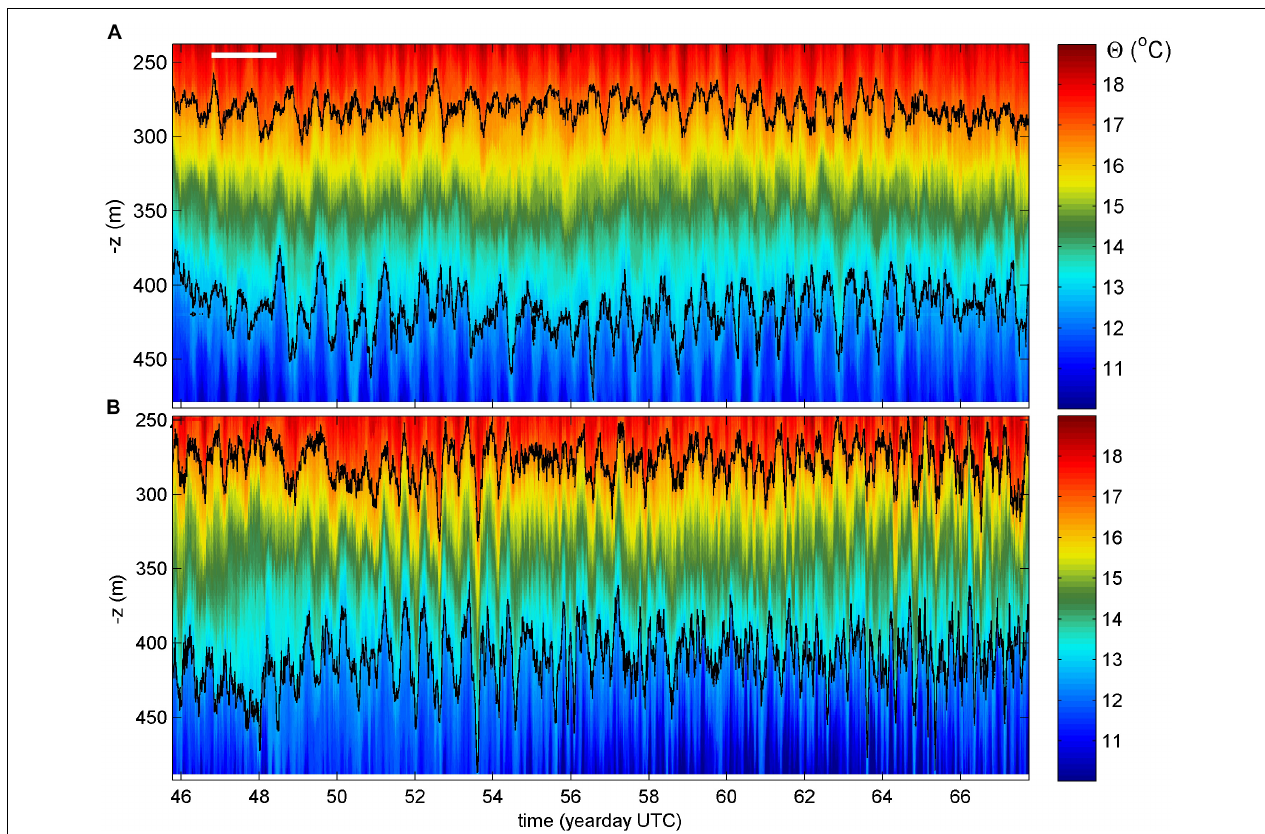
FIGURE 5 | Depth-time overview of Conservative Temperature from moored high-resolution T-sensors, with missing sensors interpolated (see text). The time range is common for both moorings and the local bottoms are at the horizontal axes. The black contours are for 12.7 and 16.7 ◦ C. (A) MN. The white horizontal bar indicates the local inertial period. (B) MS. Time here and all other plots is in